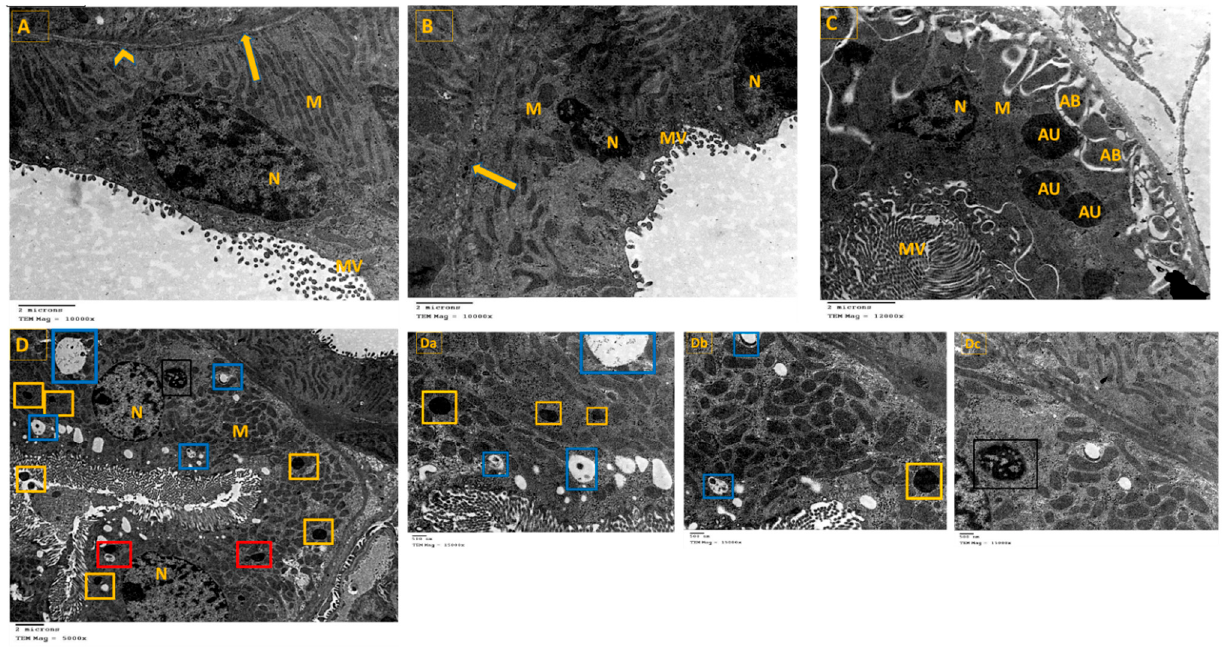
Figure 6. Effect of rapamycin and fasting on autophagosome formation in kidney tissue of rats after administration of STZ as viewed by TEM. ( A ) Renal proximal tubular cells of the control group showing normal nucleus (N), elongated abundant mitochondria (M) arranged perpendicular on trilamillar basal lamina (arrow), tight junctions (arrowhead). ( B ) Renal proximal tubular cells of STZ rats showing nucleus (N) with severe indentation of nuclear membrane, chromatin condensation, and margination suggestive of apoptotic processes. There is dilated intercellular space (arrow) showing swelling of endothelial cells (arrowhead). Mitochondria (M) are of different shapes and size which are also disoriented and showing swelling. ( C ) Renal proximal tubular cells of STZ rats that were administered rapamycin showing shrunken indentated nucleus (N), membrane blebbing, multiple apoptotic bodies (AB), and few autophagosomes (AU). There is great loss of cytoplasmic organelles, and the few abundant mitochondria (M) are disorganized. ( D ) Renal proximal tubular cells of fasting STZ rats showing normal nucleus (N), numerous intact elongated mitochondria (M), vacuoles (V), and tight intercellular space (arrow). Importantly, large number of cells had autophagosomes (yellow square) dispersed among them. Additionally, a higher magnification of parts of Figure 6 was provided as ( Da – Dc ) to demonstrate the four sequential steps in the autophagy process which are: (i) The initiation (formation of isolation membrane) (blue square), (ii) The formation of autophagosomes (yellow square), (iii) The fusion of autophagosome with lysosome (red square), (iv) The maturation of autophagosomes into autolysosomes (black square).